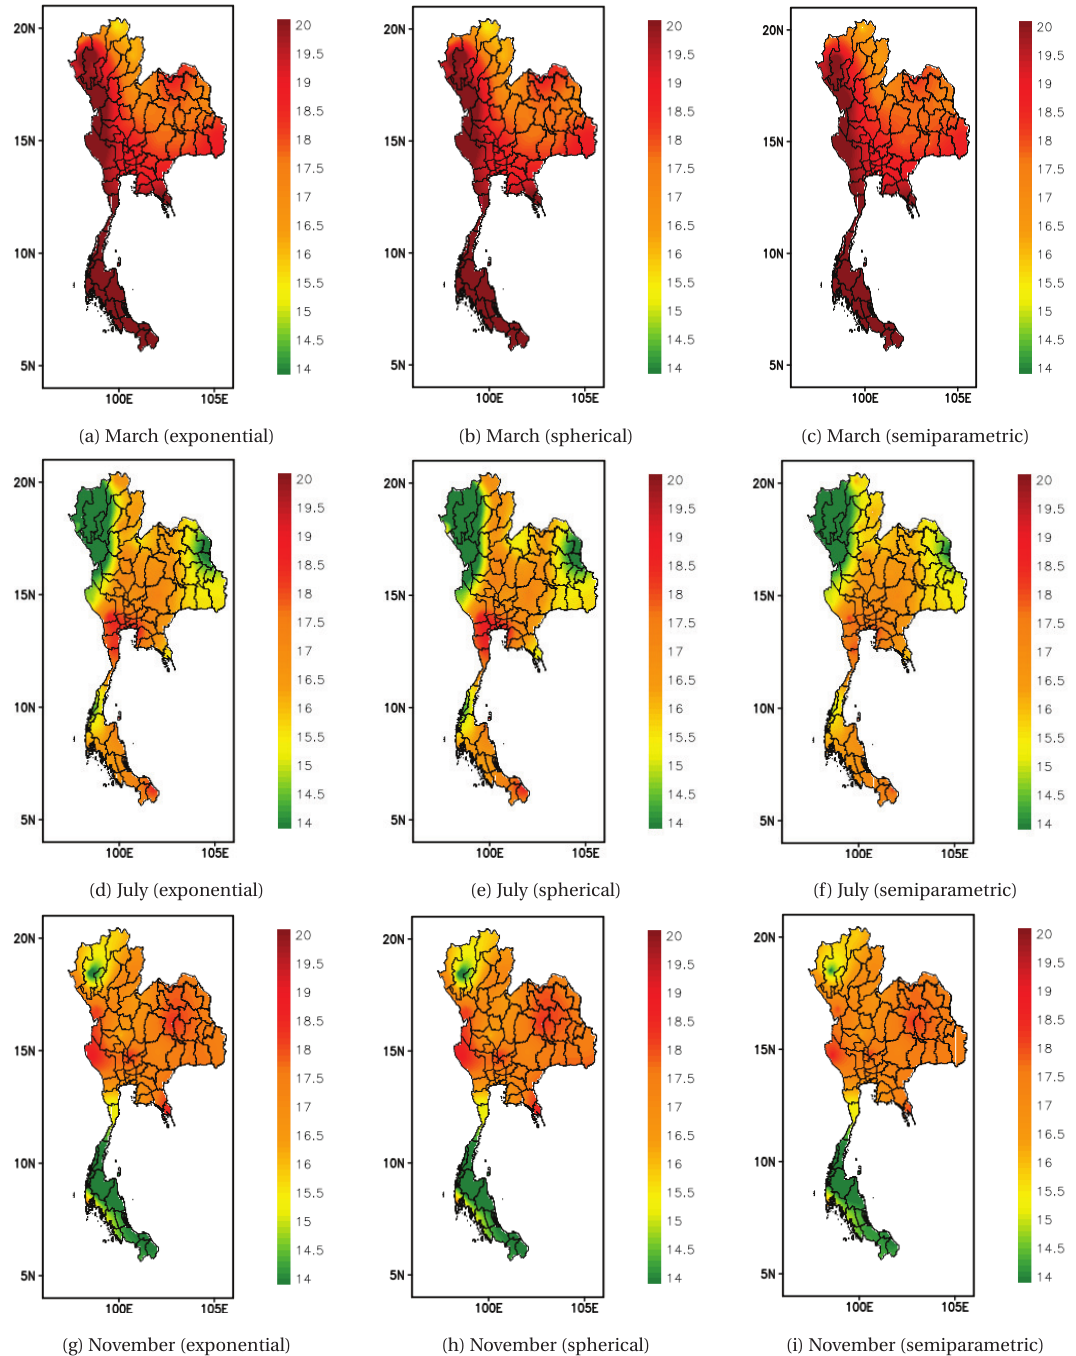
Figure 4. The maps of the predicted montly averages of daily solar radiation for March, July and November using exponential model, spherical model and semiparametric